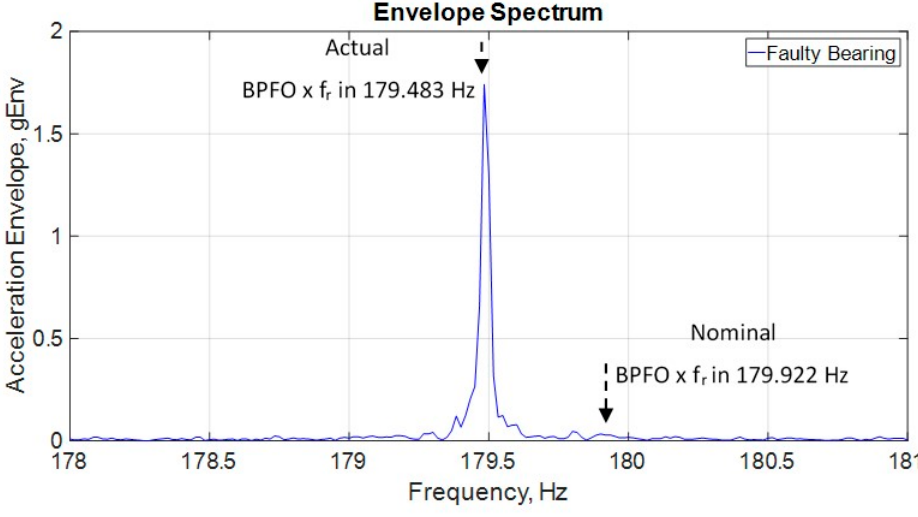
Figure 7. Acceleration envelope spectrum with zoom in the actual BPFO x f r in 179.483 Hz.